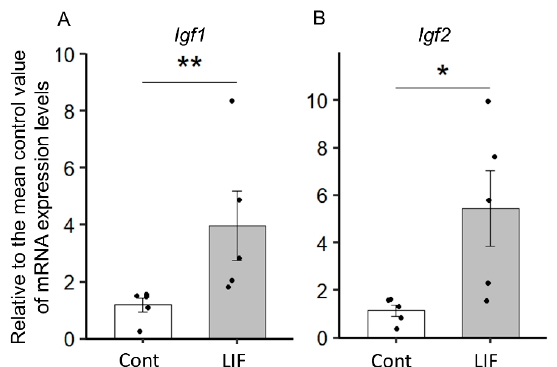
Figure 2. LIF injection into the fetal cerebral ventricle induces Igf1 ( A ) and Igf2 ( B ) mRNA expression in fetal dorsal cerebrum. Quantitative real-time PCR analyses revealed the increased expression of Igf1 and Igf2 in the fetal dorsal cerebrum upon direct administration of LIF into the lateral ventricle. Data are represented as ratios of the mean value of LIF-injected group (n = 5) versus control group (n = 5). Error bars: SEM. Statistical difference was determined by Mann–Whitney U test. * p < 0.05, ** p < 0.01.